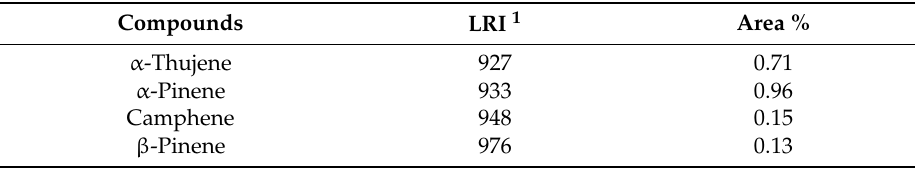
Table 1. Composition of the essential oil of Thymbra capitata (L.)